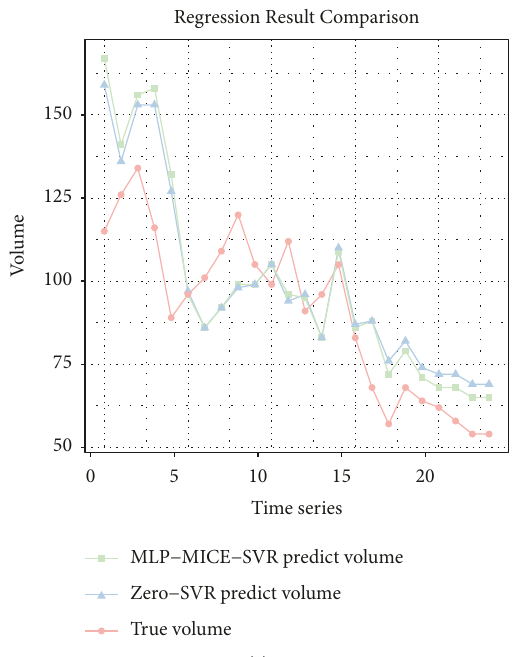
Figure 10: MLP-MICE imputation application analysis results of VDS-1 to VDS-5. (a) VDS-1, (b) VDS-2, (c) VDS-3, (d) VDS-4, and (e)